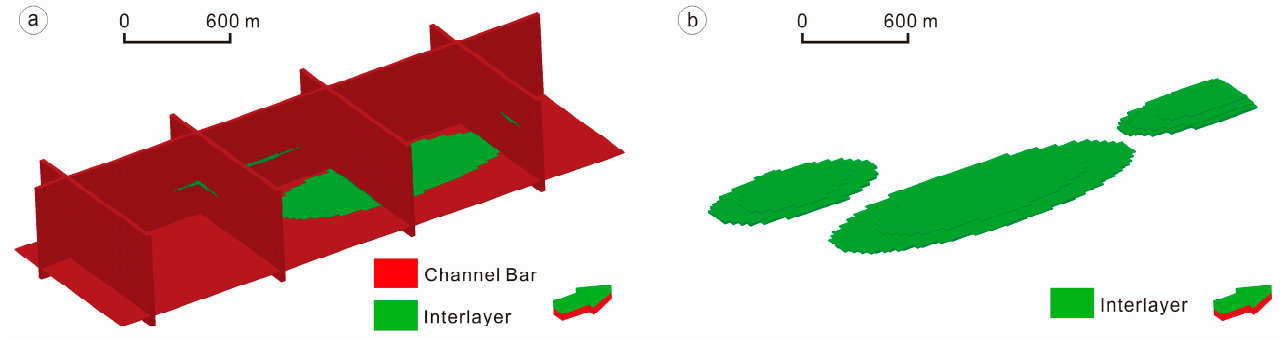
Figure 10. Third hierarchical TI 3-1 based on 5–3 level architecture units. ( a ) Fence diagram, ( b ) interlayer hollowing diagram.